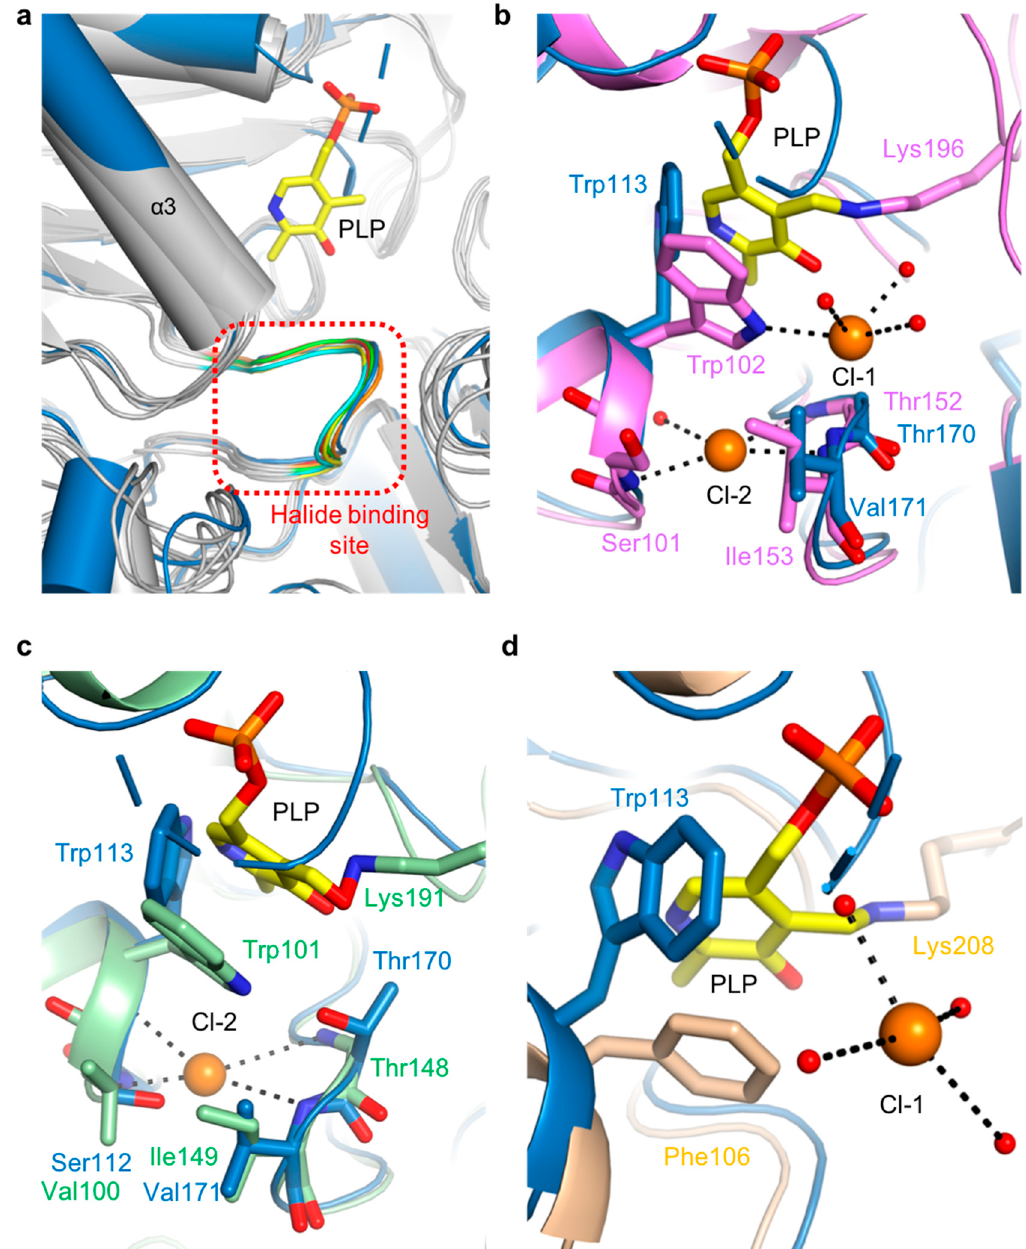
Figure 7. Comparison of halide-binding sites. ( a ) Overlaid structures of Sc PSAT (blue) with its five homologs (grey) indicating the halide-binding site (red-dashed square). The loops of Sc PSAT (blue), Hs PSAT (PDB code: 3E77; orange), At PSAT (PDB code: 6CZX; red), Pa PSAT (PDB code: 4XK1; green), Aa PSAT (PDB code: 1W23; yellow), and Ec PSAT (PDB code: 1BJO; cyan), and the PLP bound in Aa PSAT (yellow) are visualized. ( b ) Detailed view of halide-binding site by superimposed structures of Sc PSAT (blue) and Aa PSAT (pink). Two chloride ions (Cl-1 and Cl-2; orange), coordinated water molecules (red), and PLP bound by Aa PSAT (yellow) are shown. ( c ) Detailed view of halide-binding site by superimposed structures of Sc PSAT (blue) and Eh PSAT (green). Cl-2 (orange) and PLP bound by Eh PSAT (yellow) are shown. ( d ) Detailed view of halide-binding site by superimposed structures of Sc PSAT (blue) and Pyrococcus horikoshii PSAT ( Ph PSAT; PDB code: 2DR1; light brown). Cl-1 (orange), coordinated water molecules (red), and PLP bound by Ph PSAT (yellow) are shown.